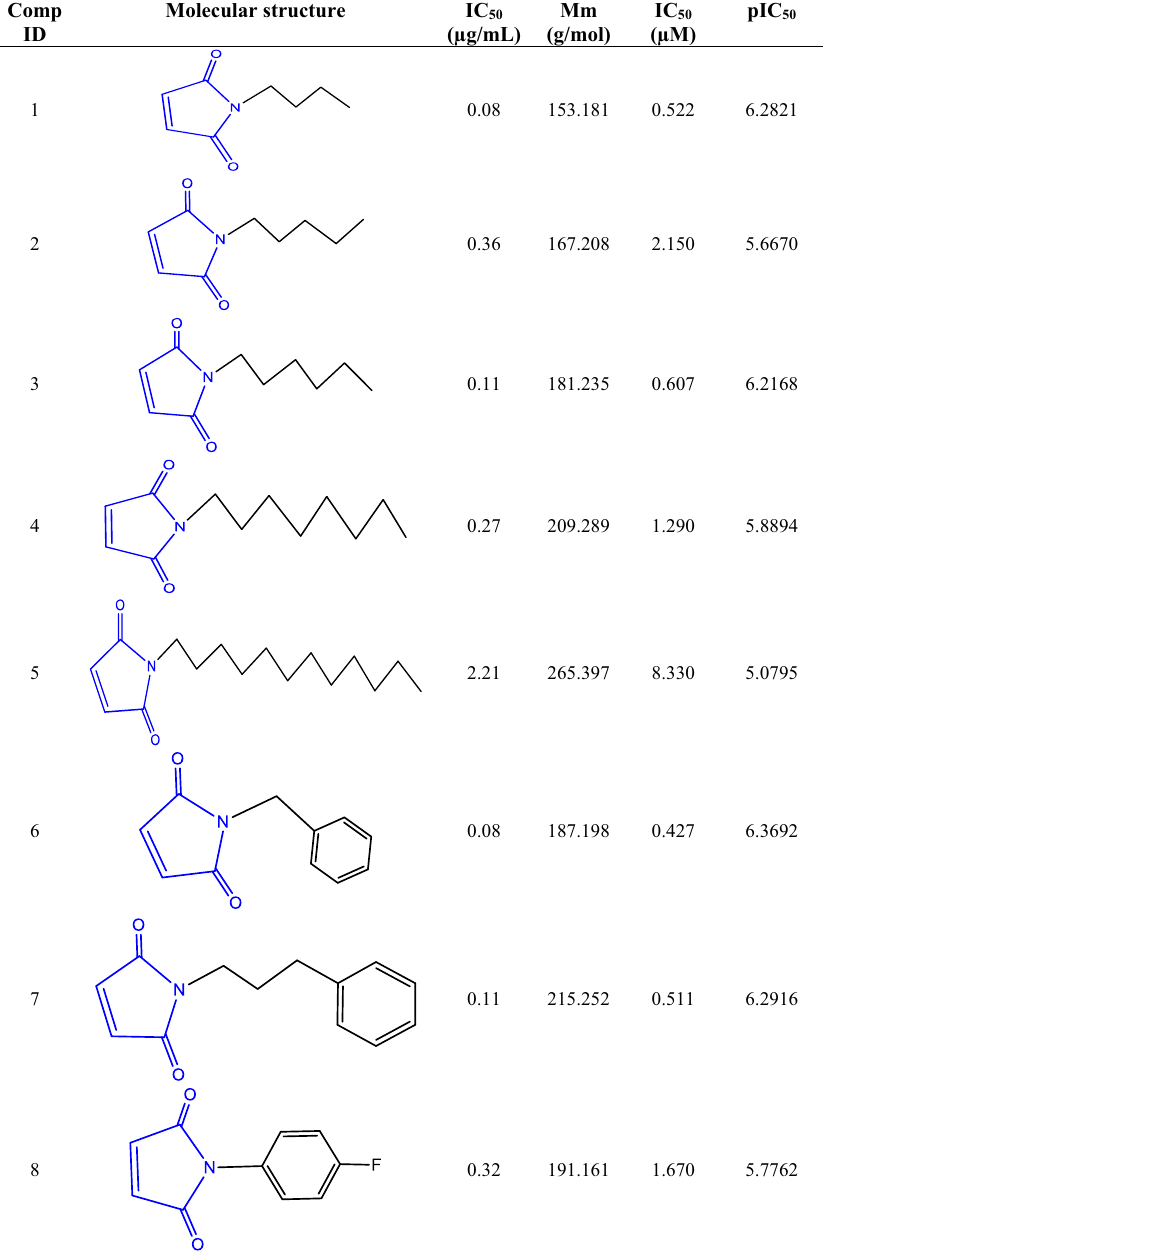
Table 1 Molecular structures of maleimides and their anti-leishmanial activities (IC Comp